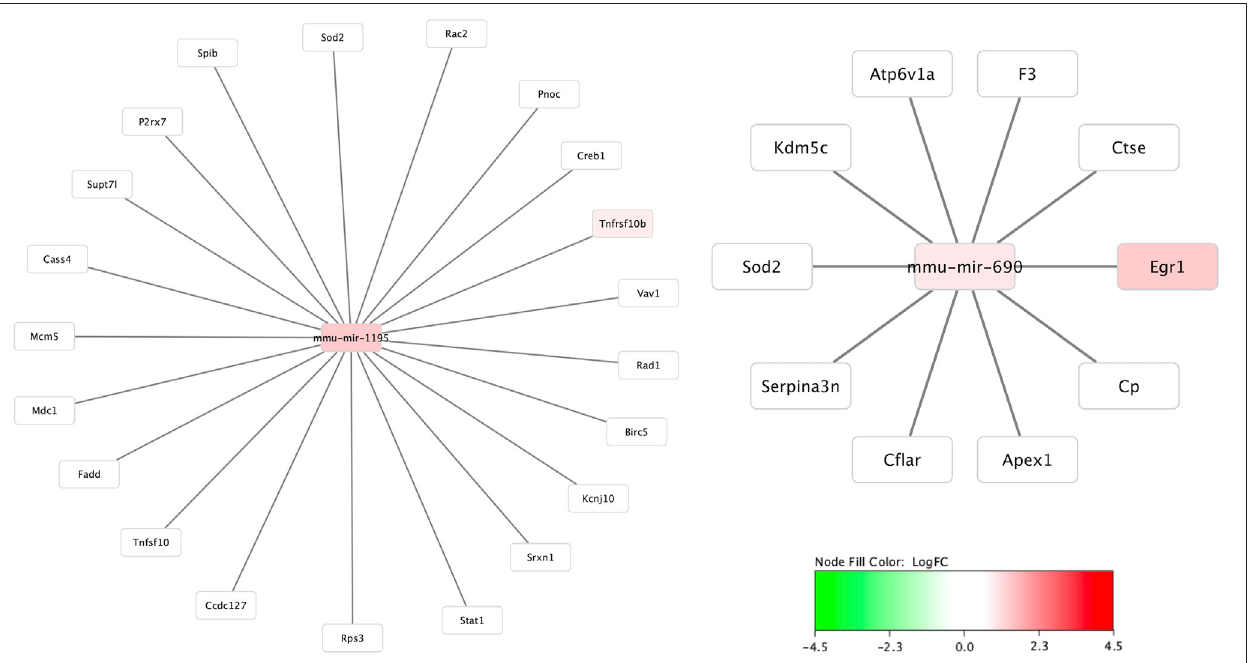
FIGURE 5 | MicroRNA to messenger RNA (miRNA-mRNA) networks in the cortex. The only two miRNAs that demonstrated signi fi cant differential expression at 30 min and were closely linked to mRNAs also signi fi cantly altered at 30 min after injury were miR-1195 and -690. Neither the striatum/thalamus nor cerebellum expression data resulted in signi fi cant miRNA-mRNA networks.